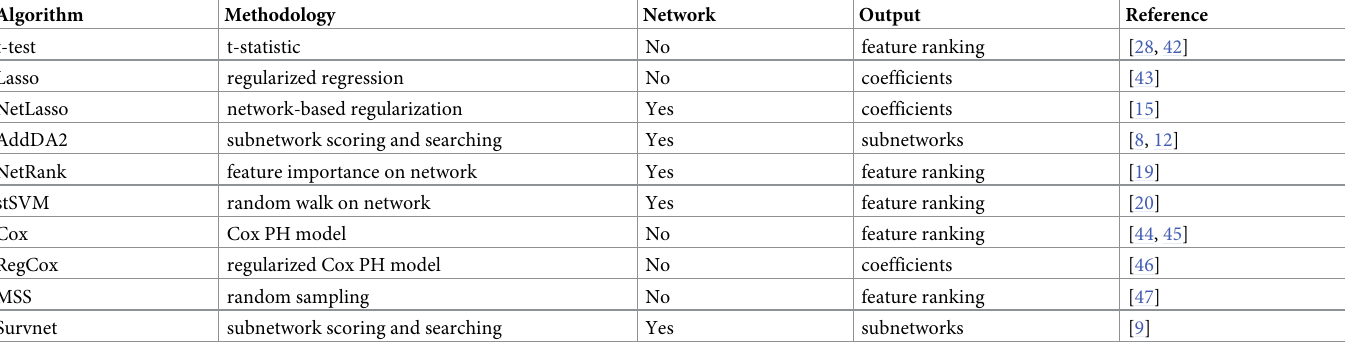
Table 2. Overview of the 10 feature selection algorithms. We listed below their main methodologies, whether network information was integrated, the algorithmic out- put and reference.